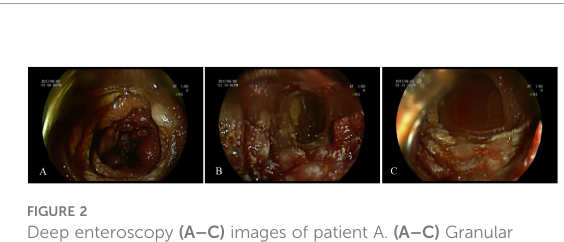
FIGURE 2 Deep enteroscopy (A – C) images of patient A. (A – C) Granular hyperplasia of the mucosa 190 – 200 cm away from the ligament of Treitz, and the surface was erosive, with white speckles